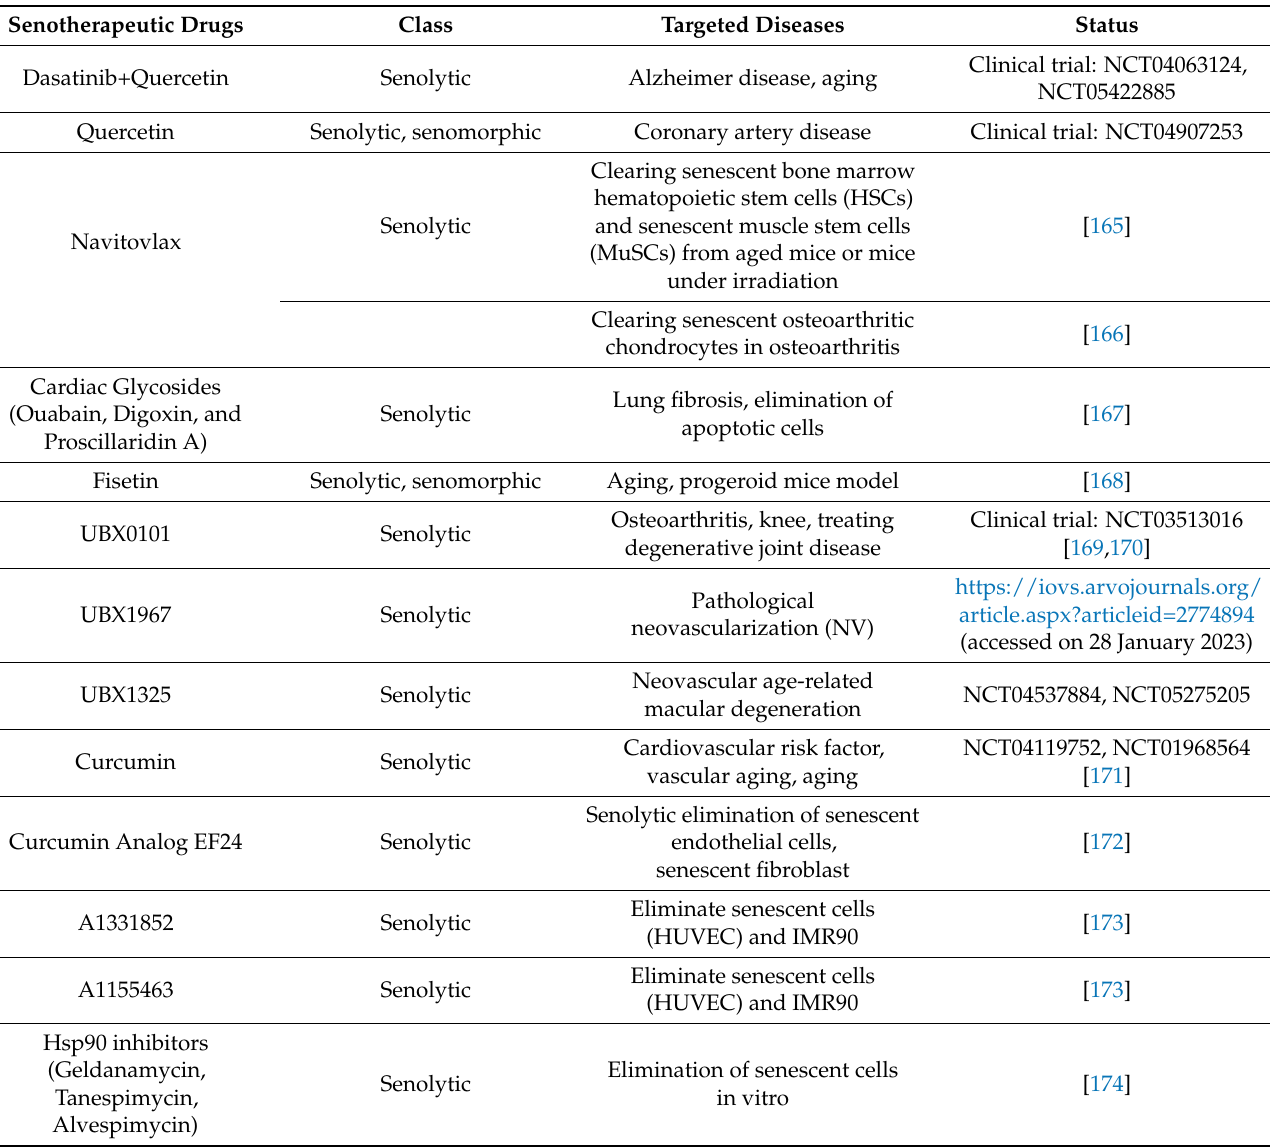
Table 2. Senotherapeutic drugs targeting senescent cells or SASPs in different age-related diseases. Senotherapeutic